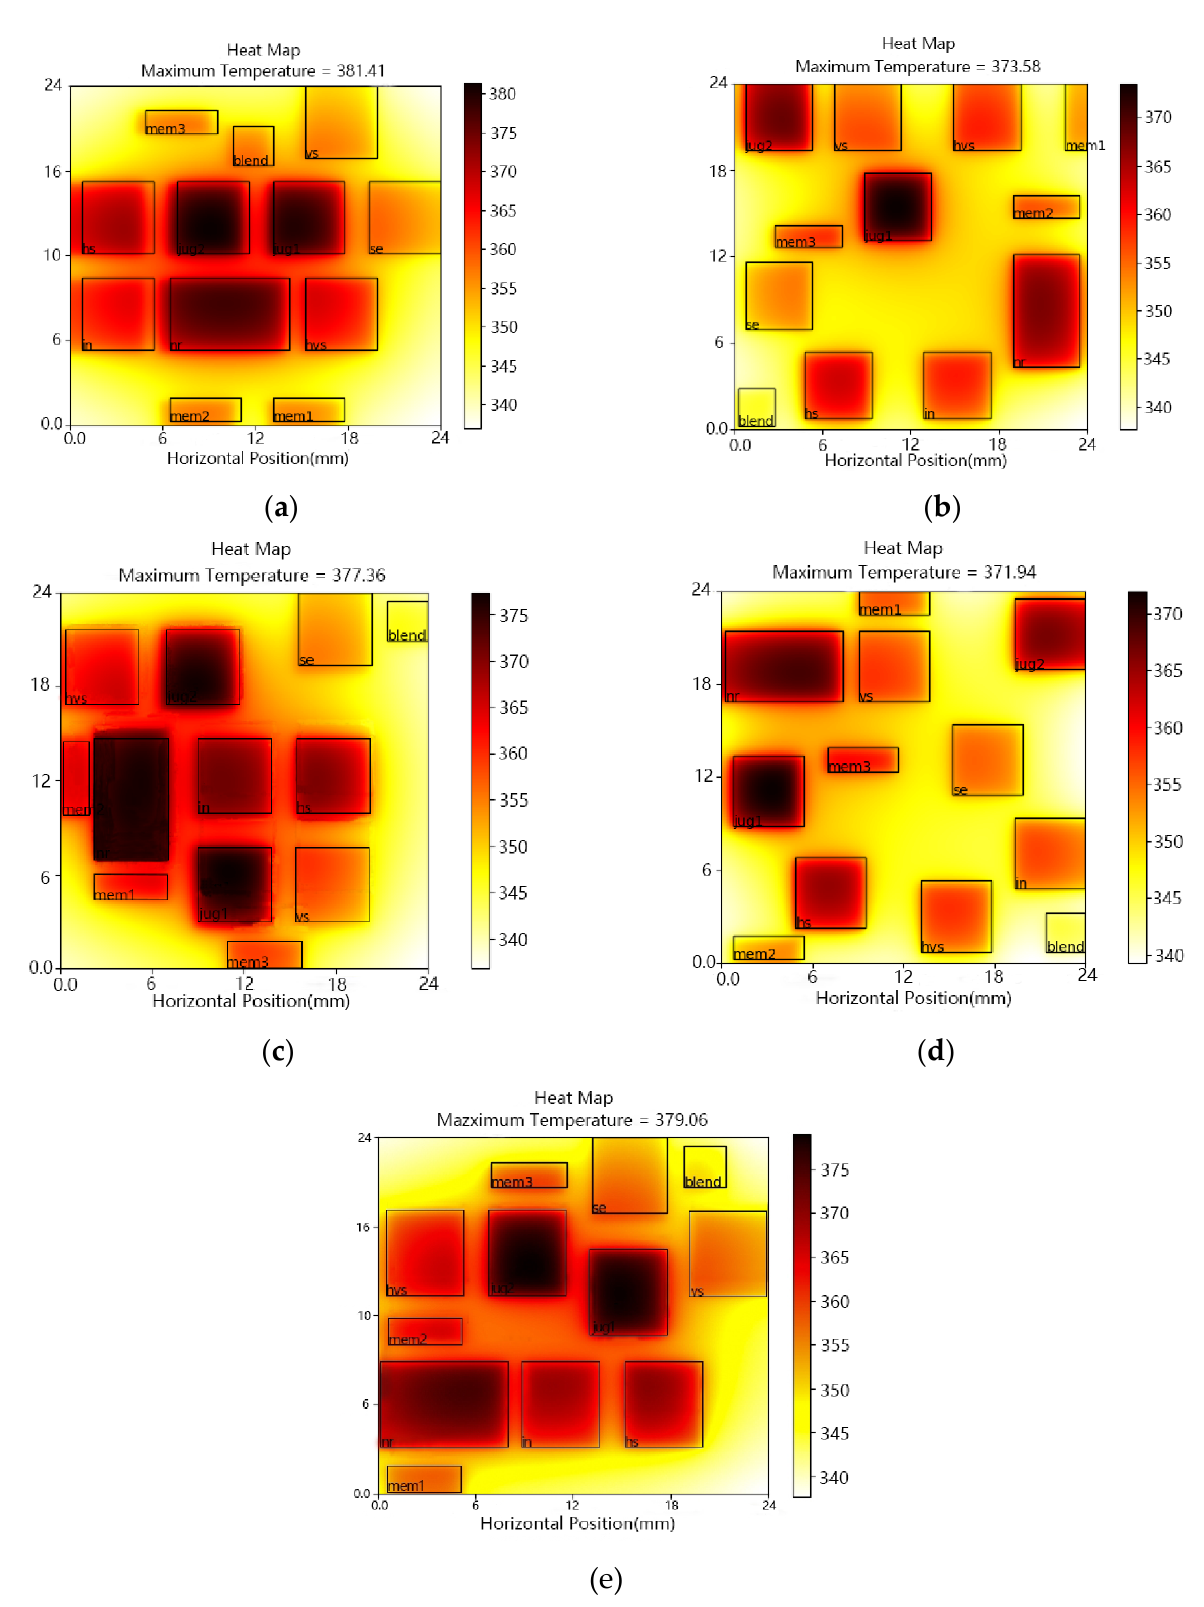
Figure 9. ( a ) Initial layout of MWD; ( b ) multi-objective optimization result with α equal to 0.5; ( c ) multi-objective optimization result with α equal to 0.8; ( d ) multi-objective optimization result with α equal to 0.2; and ( e ) communication consumption single-objective optimization result.